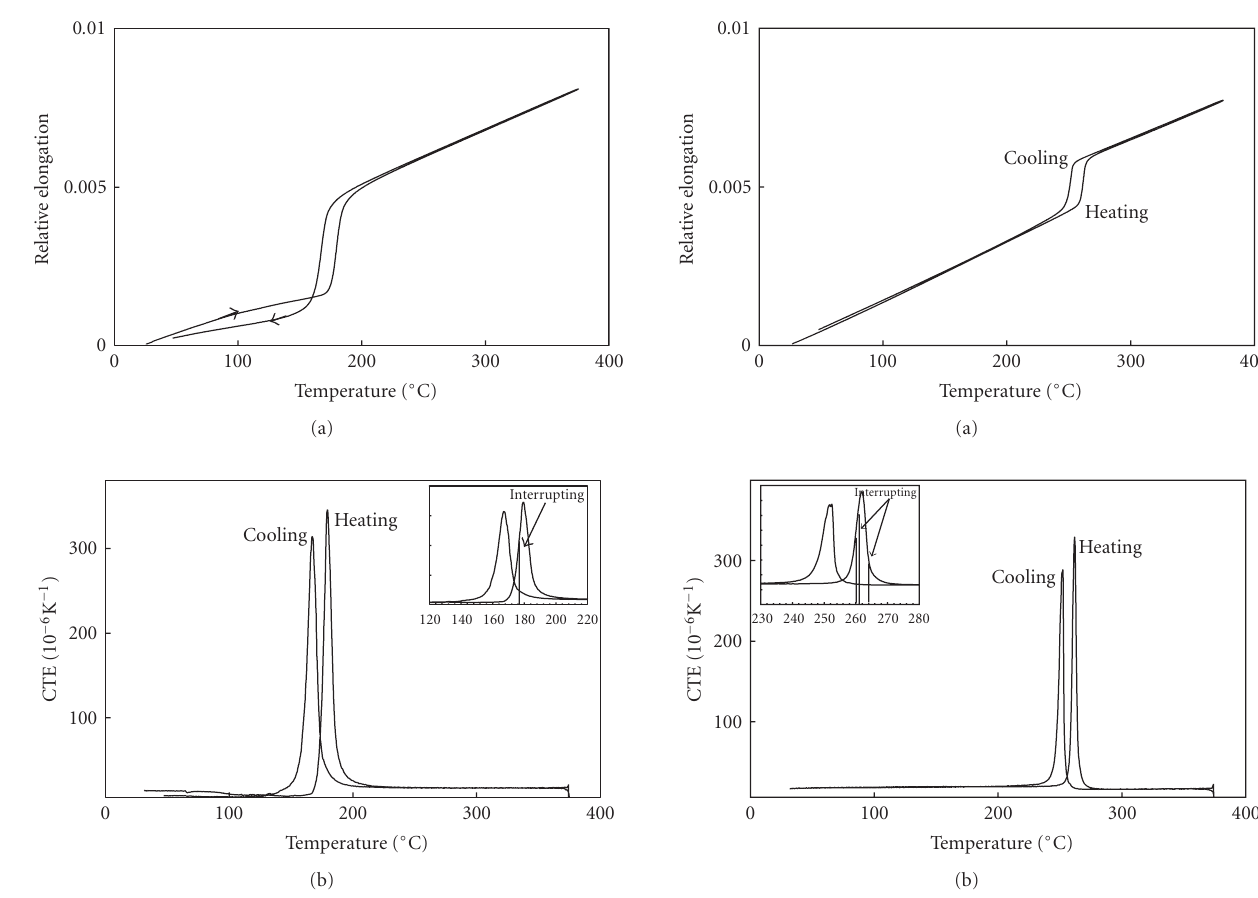
Figure 1: Temperature dependence of (a) the relative elongation and (b) the CTE for Ni 53 . 6 Mn 27 . 1 Ga 19 . 3 alloy in a complete cycle.